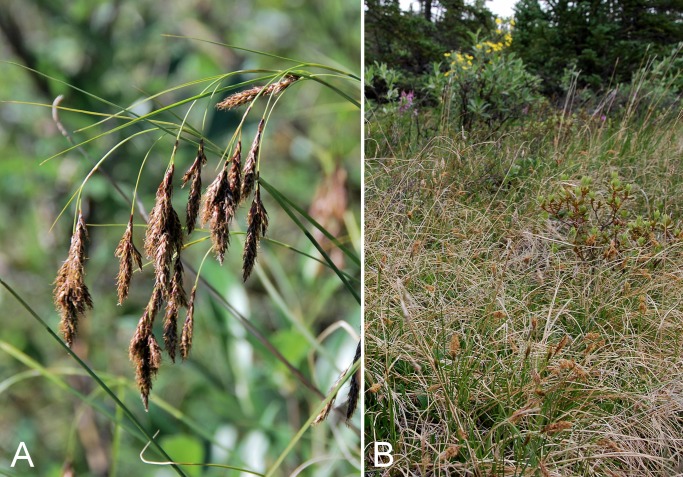
Carex petricosa subsp.(A) Inflorescence, Saarela et al. 4173. (B) Habitat, Saarela et al. 3553. Photographs by J. M. Saarela.